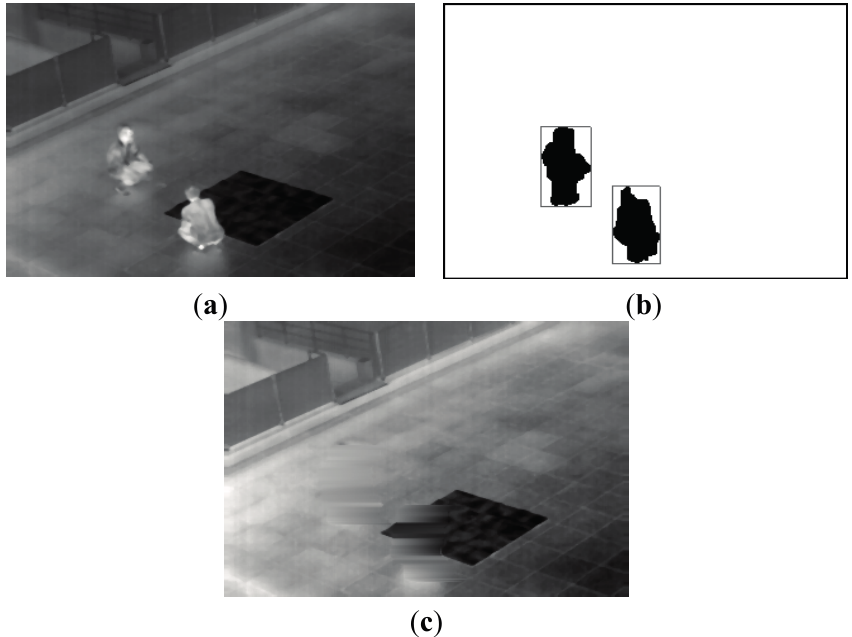
Figure 5. The second example for obtaining a background image from our database: ( a ) preliminary background image obtained by temporal averaging; ( b ) extracted human areas; and ( c ) the generated final background